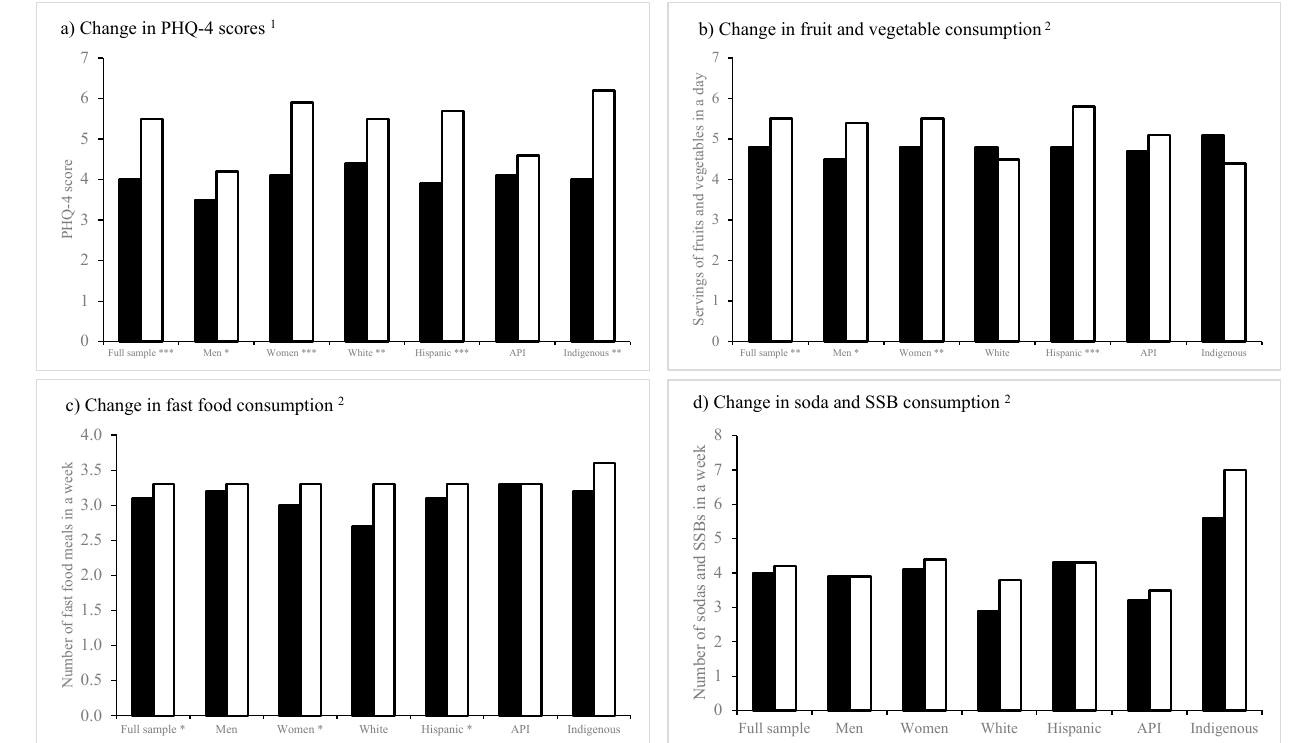
FIGURE 1 . Perceived changes in food and beverage choices and mental health indicators among survey participants from the Health During the COVID-19 Pandemic Student Survey stratified by gender and race, California State University Los Angeles, 2021 1 a legend: Before the COVID-19 pandemic Over the last two weeks; 2 b-d legend: Before the COVID-19 pandemic In the past month; * p <0.05, ** p <0.01, *** p <0.0001